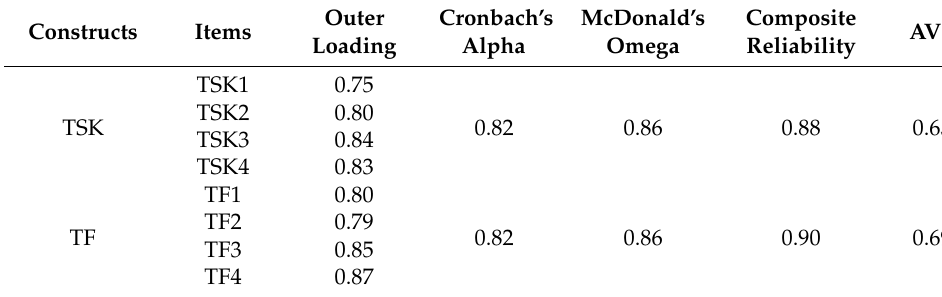
Figure 2. Theoretical cause–effect framework. Table 6. Outer loading, reliability and